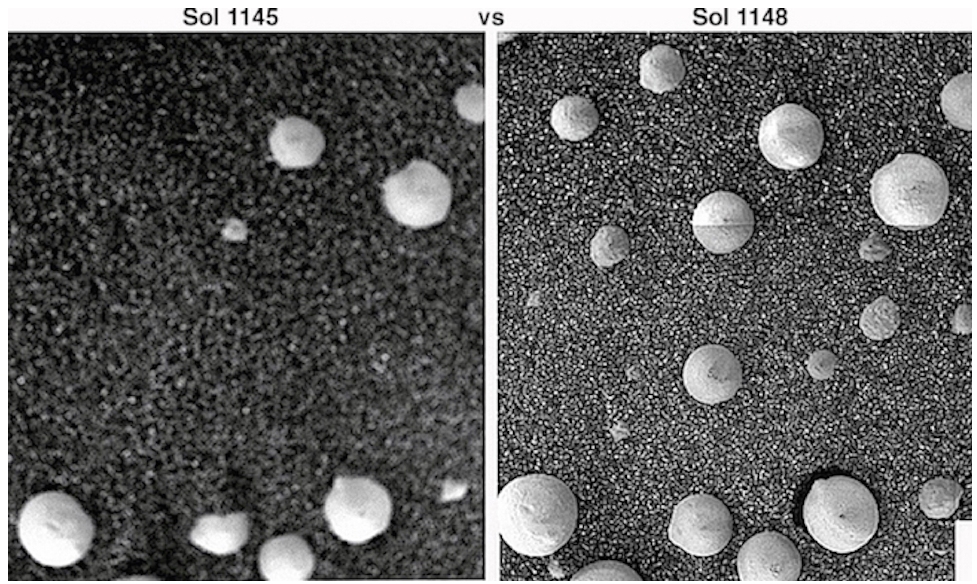
Figure 6. Mars. Photographed in Eagle Crater by the rover Opportunity. Comparing Sol 1145-left vs Sol 1148-right: Growth of twenty-three Martian specimens over three days, twelve of which emerged from beneath the soil and all of which increased in size. Ground level wind speeds between 40 to 70 m/h are required to move coarse grained soil on Mars, and no strong winds, dust clouds, dust devils, or other in- dications of strong winds were observed, photographed, or reported during those three days in this vicinity of Mars. Nor does the Sol 1148 photograph show any evidence that the surface has been disturbed by wind, as there are no parallel lineaments, ripples, waves, crests, or build-up of soil on one side of the specimens as would be expected of a directional wind. Differences in photo quality are secondary to changes in camera-closeup-focus by NASA. (Reproduced with permission from Joseph et al.